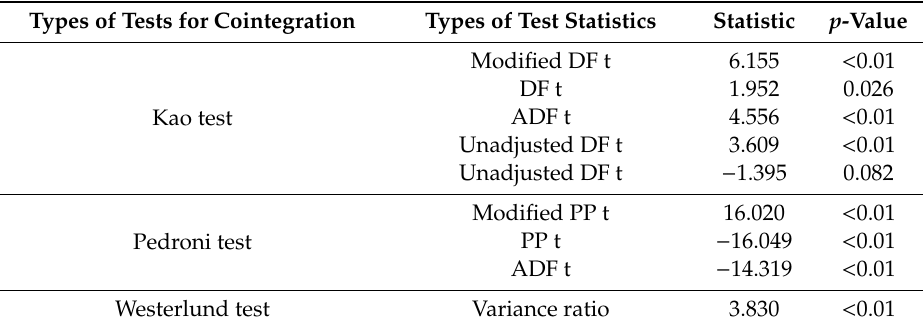
Table 3. Results of panel cointegration